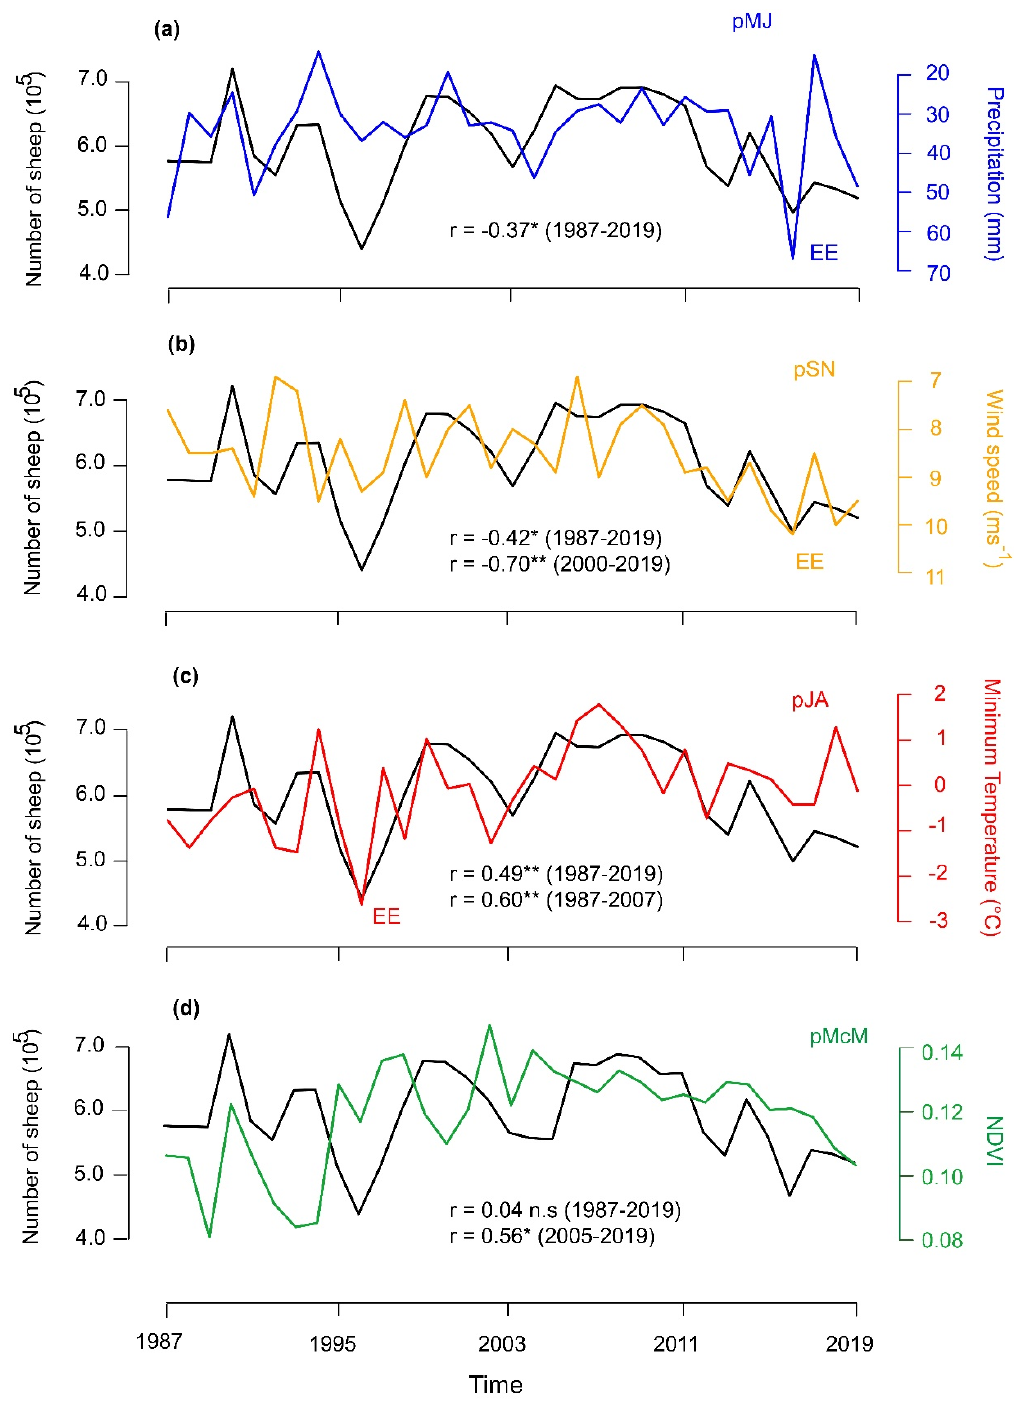
Figure 6. Pearson correlation analysis of sheep production (SP) with regional climatic variability and NDVI data as a measure of ANPP. Number of sheep (black line) against ( a ) previous May and June precipitation (pMJ: blue line), ( b ) previous September and November wind speed (pSN: orange line), ( c ) minimum temperature of previous July and August (pJA: red line) and ( d ) NDVI from NOAA of previous May and current May (pMcM: green line). The correlations coefficient are indicated at p < 0.05 (*), p < 0.01 (**) and no significant (n.s). Note that precipitation and wind speed values are displayed inverted for better understanding.